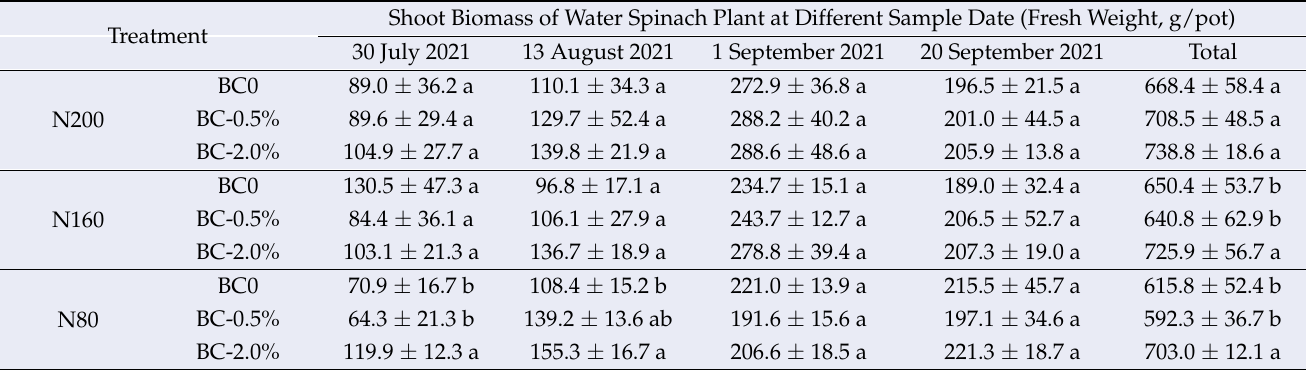
Table 1. Responses of production (shoot biomass) of water spinach to hydrochar amendments under three N-inputs.